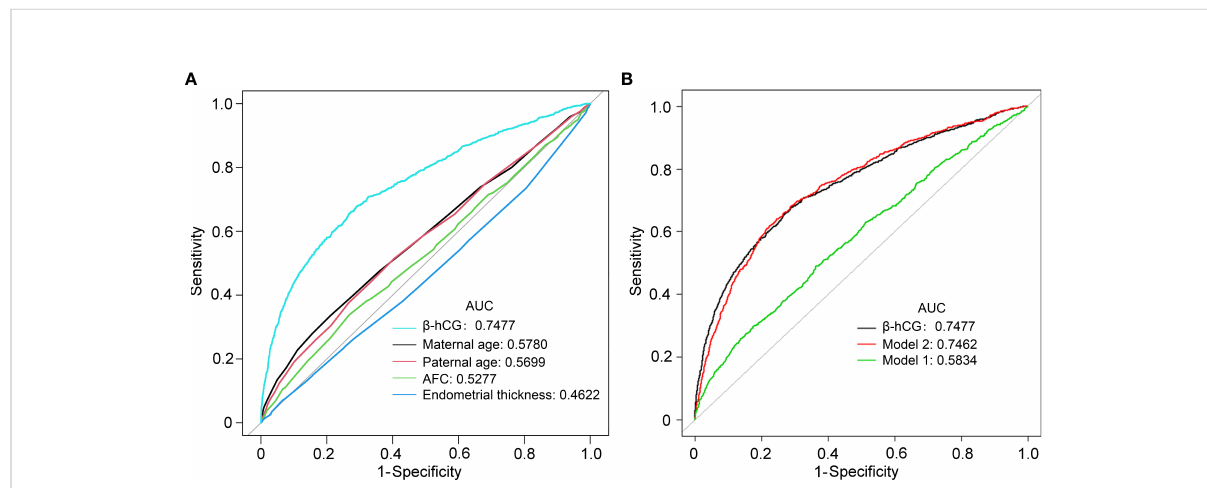
FIGURE 4 Receiver operating characteristic (ROC) curves comparing the potential of different variables to predict early pregnancy loss. (A) The prediction of individual variables. (B) Predictive ability of different models of early pregnancy loss. Model 1 included maternal age, paternal age, AFC, and endometrial thickness; Model 2, model 1 plus b